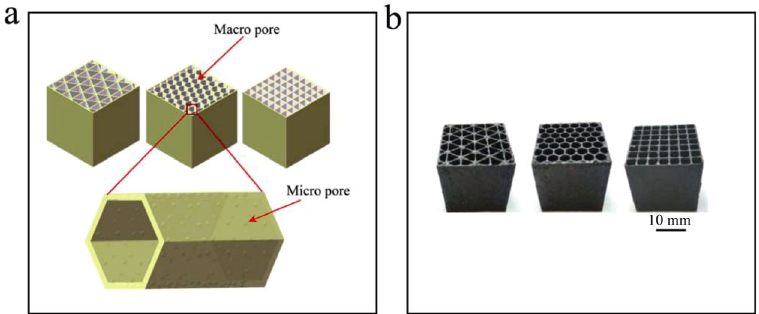
Fig. 11 (a) Schematic diagrams and (b) photographs of macro–micro hierarchically porous SiC structures prepared by SLS. Reproduced with permission from Ref. [51], © Elsevier Ltd and Techna Group S.r.l. 2020.